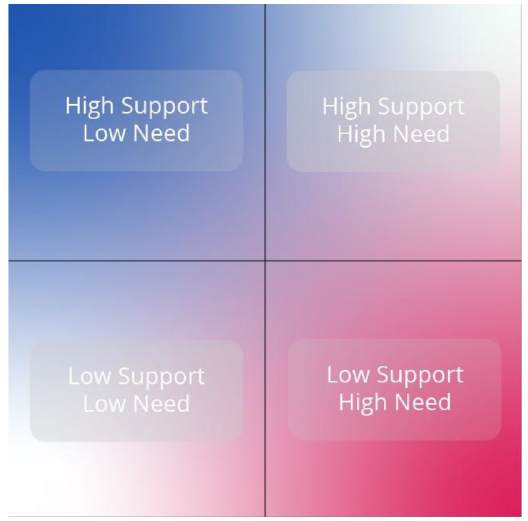
Figure 5: The colouring used to indicate the level of support or need for each